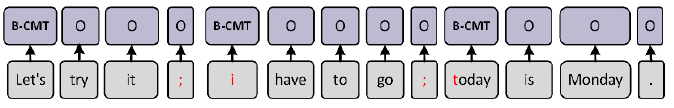
Figure 12. Example of labeled data for comment boundary detection.